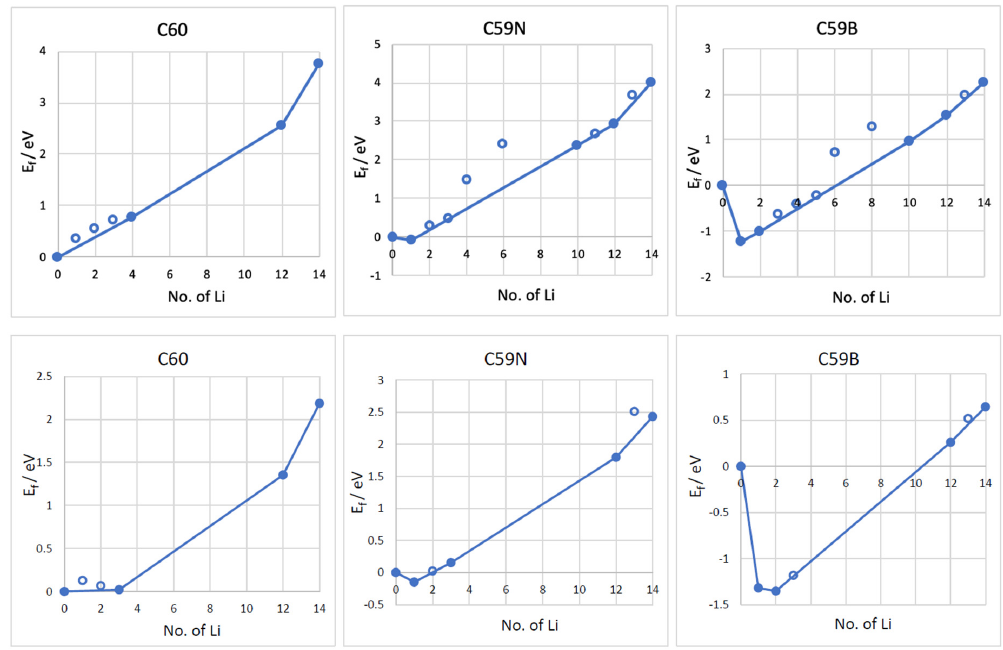
Figure 3. Formation energies ( E f ) vs. the number of Li atoms attached to the C 60 , C 59 N, and C 59 B molecules computed with B3LYP (top panels) and PBE (bottom panels) functionals. The most stable E f for each concentration are plotted. The line connects the stable phases (filled points) during Li attachment, forming a convex hull.